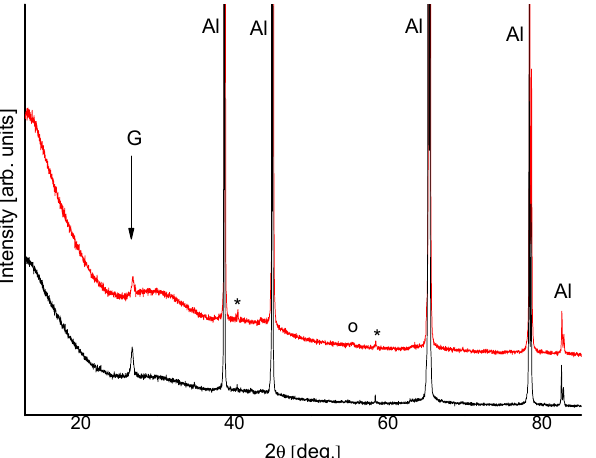
Figure 4. X-ray diffraction patterns of a sample containing 1.1 wt.% GNPs: black—before HT, red—after HT. G—graphene peak (002), Al—the peaks of Al, *—peaks of Al (beta lines), o—probable trace peak of Al 4 C 3.